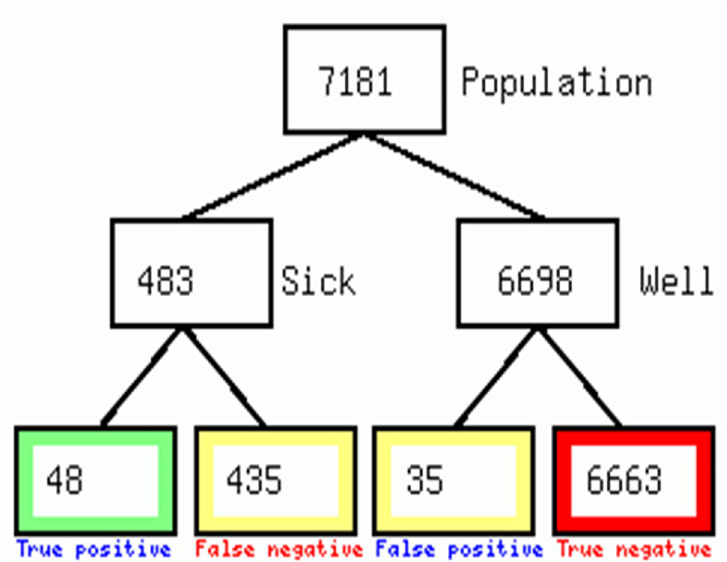
Fig 3. A diagnostic tree comparing thermal screening to Xpert Xpress SARS CoV-2 assay.